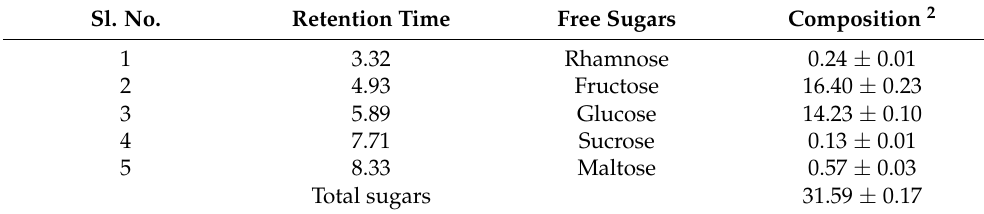
Table 3. Free sugar composition (%) of wood apple defatted fruit pulp 1 . Sl. No.